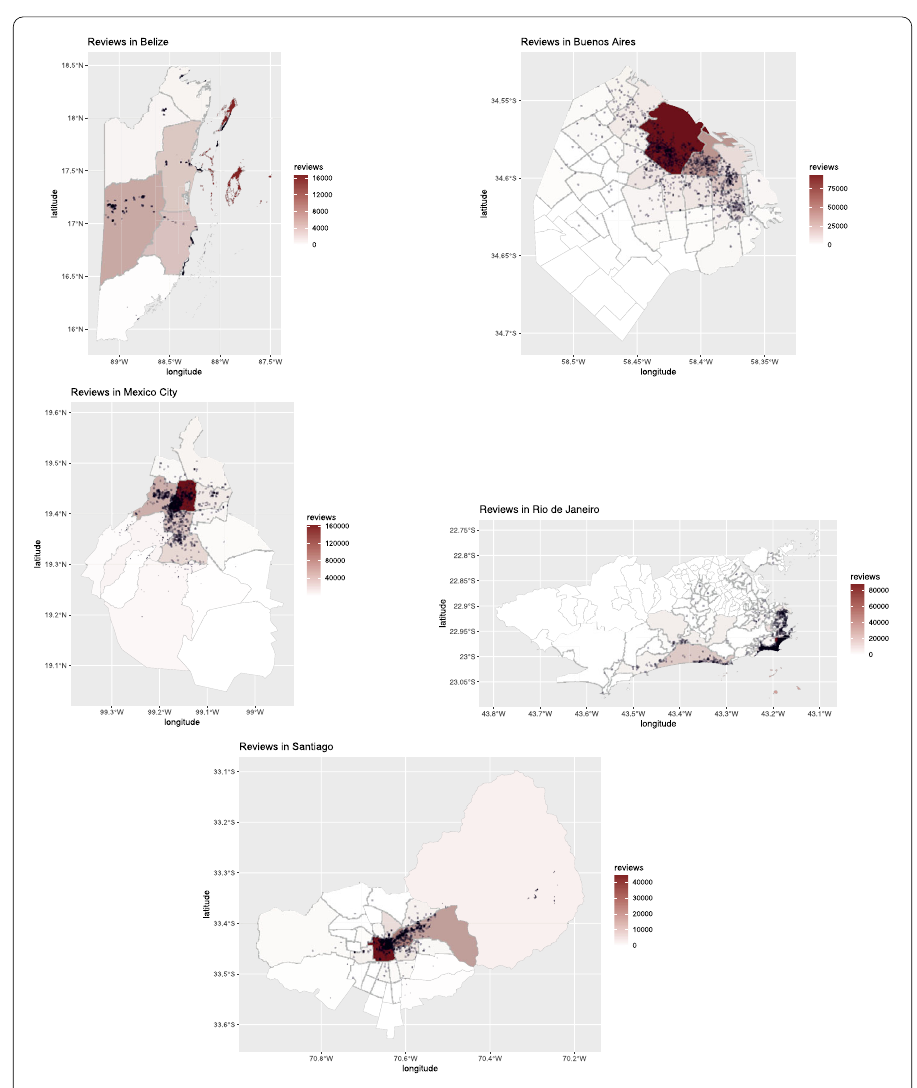
Figure 18 Demand (guest) density in the five Latin American cities